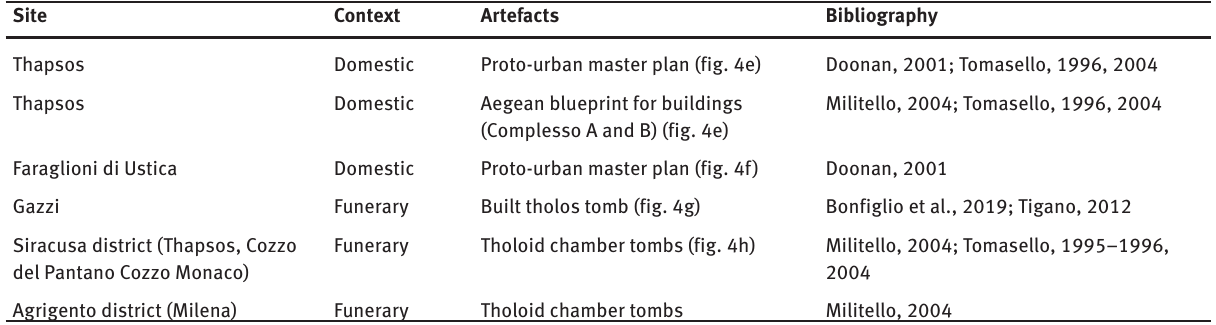
Table 6: Architectural elements of Mycenaean Origin in Middle Bronze Age